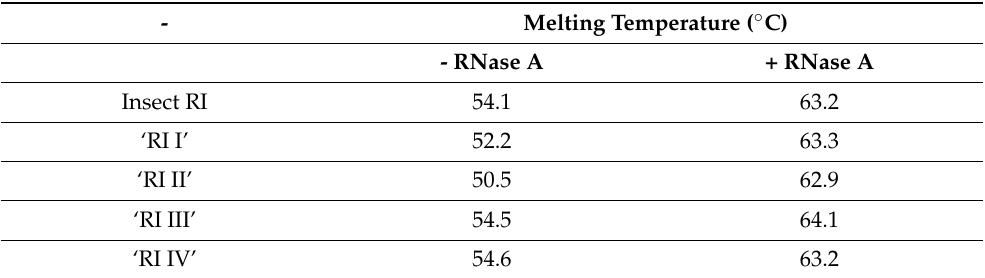
Table 2. Melting temperatures of the different ribonuclease inhibitors in the absence and presence of RNase